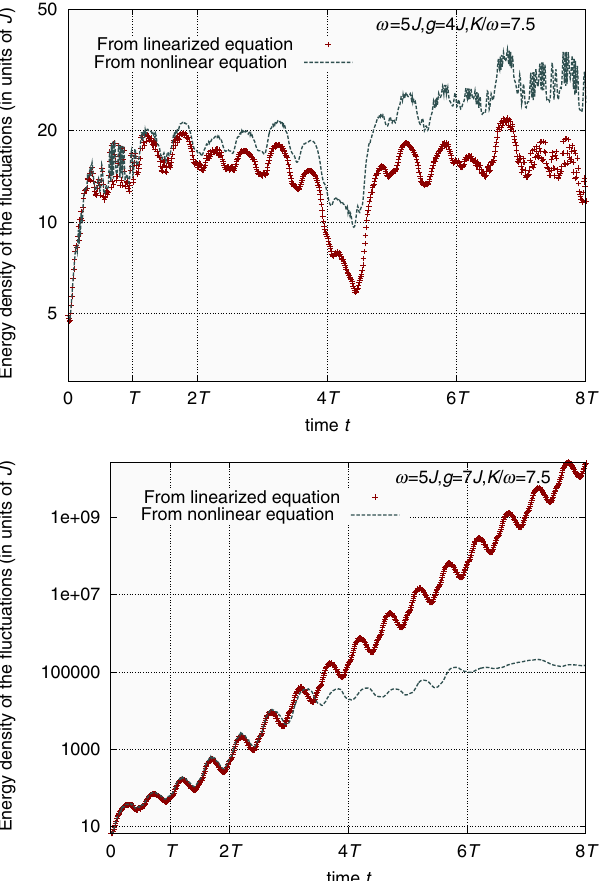
FIG. 4. Time evolution of the energy density of the fluctuations (in units of J ) over eight driving periods for two values of g . In the stable regime (top panel, g ¼ 4 ), the energy displays variations due to micromotion but no long-term growth, while in the unstable regime (bottom panel, g ¼ 7 ), the energy curve features exponential growth, defining a heating rate compatible with the maximal Lyapunov exponent Γ (see Fig. 5). The parameters are 1 and B 0 (for the initial condition, see text), ω ¼ 5 J , A q ¼ q ¼ and K= ω ¼ 7 . 5